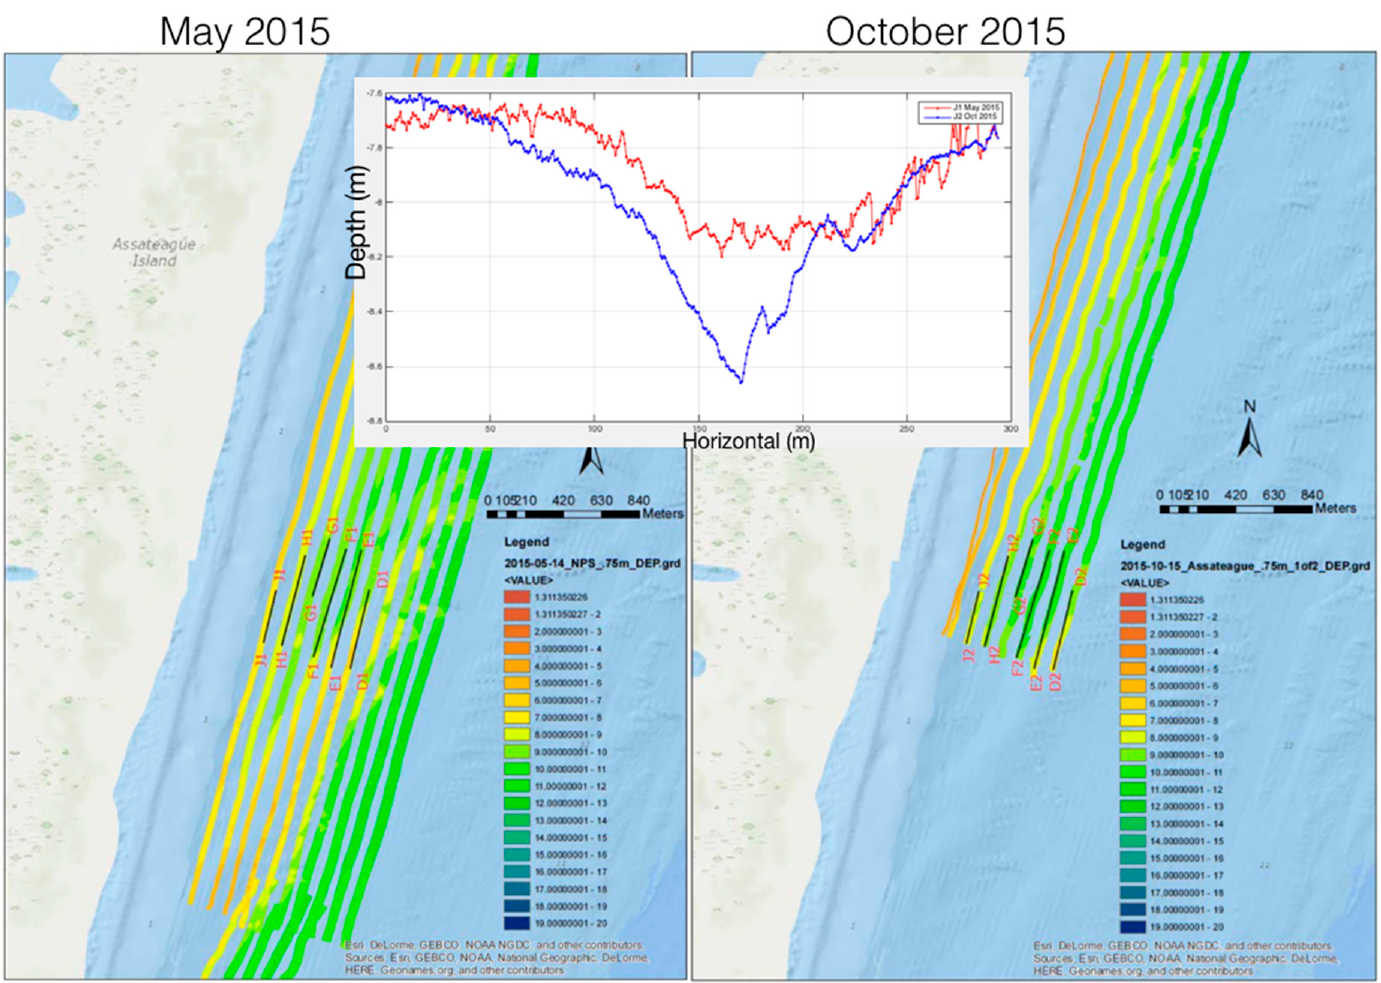
Figure 24. Bathymetry profile change after Hurricane Joaquin. Red curved line represents the bathymetry profile J1 in May 2015 and blue curved line represents the bathymetry profile J2 in October 2015. Please note the axial incision in J2